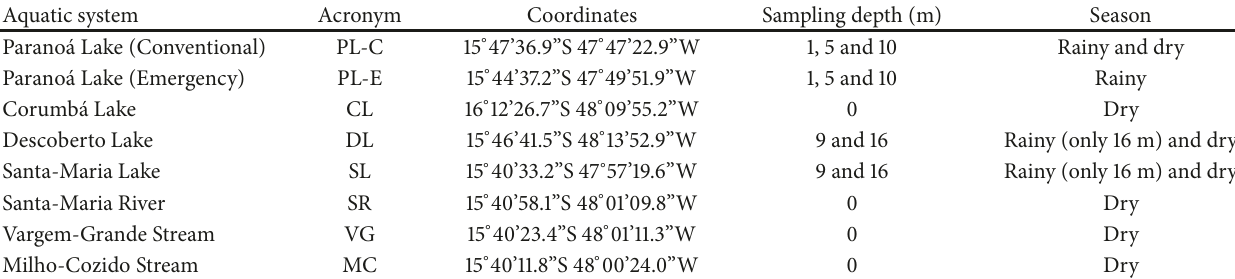
Table 1: Characteristics of the investigated samples and acronyms used in the present